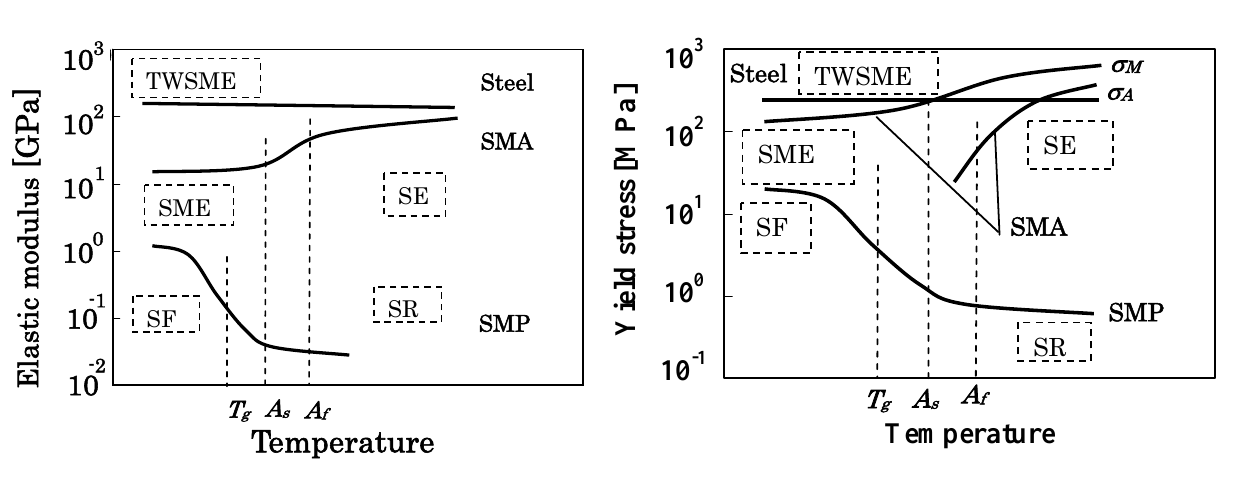
Figure 1. Dependence of elastic modulus and yield stress on temperature for SMA, SMP and